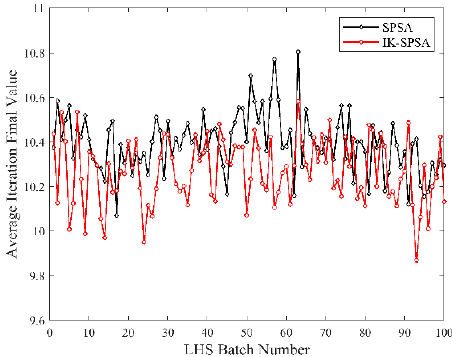
Figure 20. Average iteration final value distribution at different initial points.